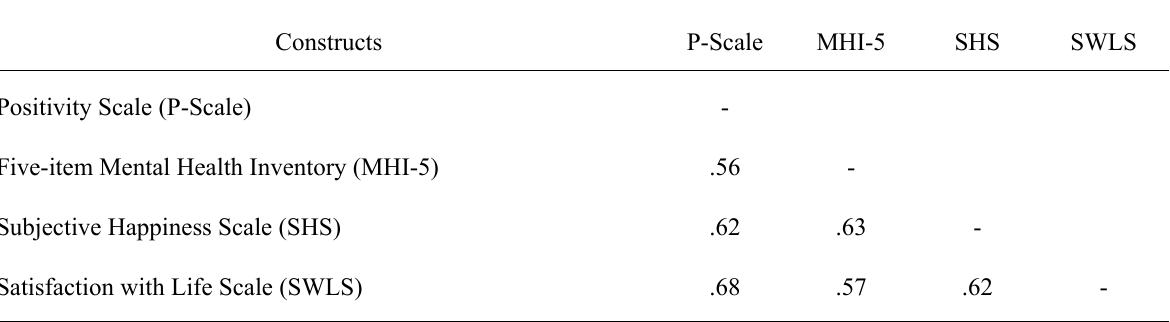
Spearman´s Correlations among P-Scale, MHI-5, SHS and SWLS Constructs Positivity Scale